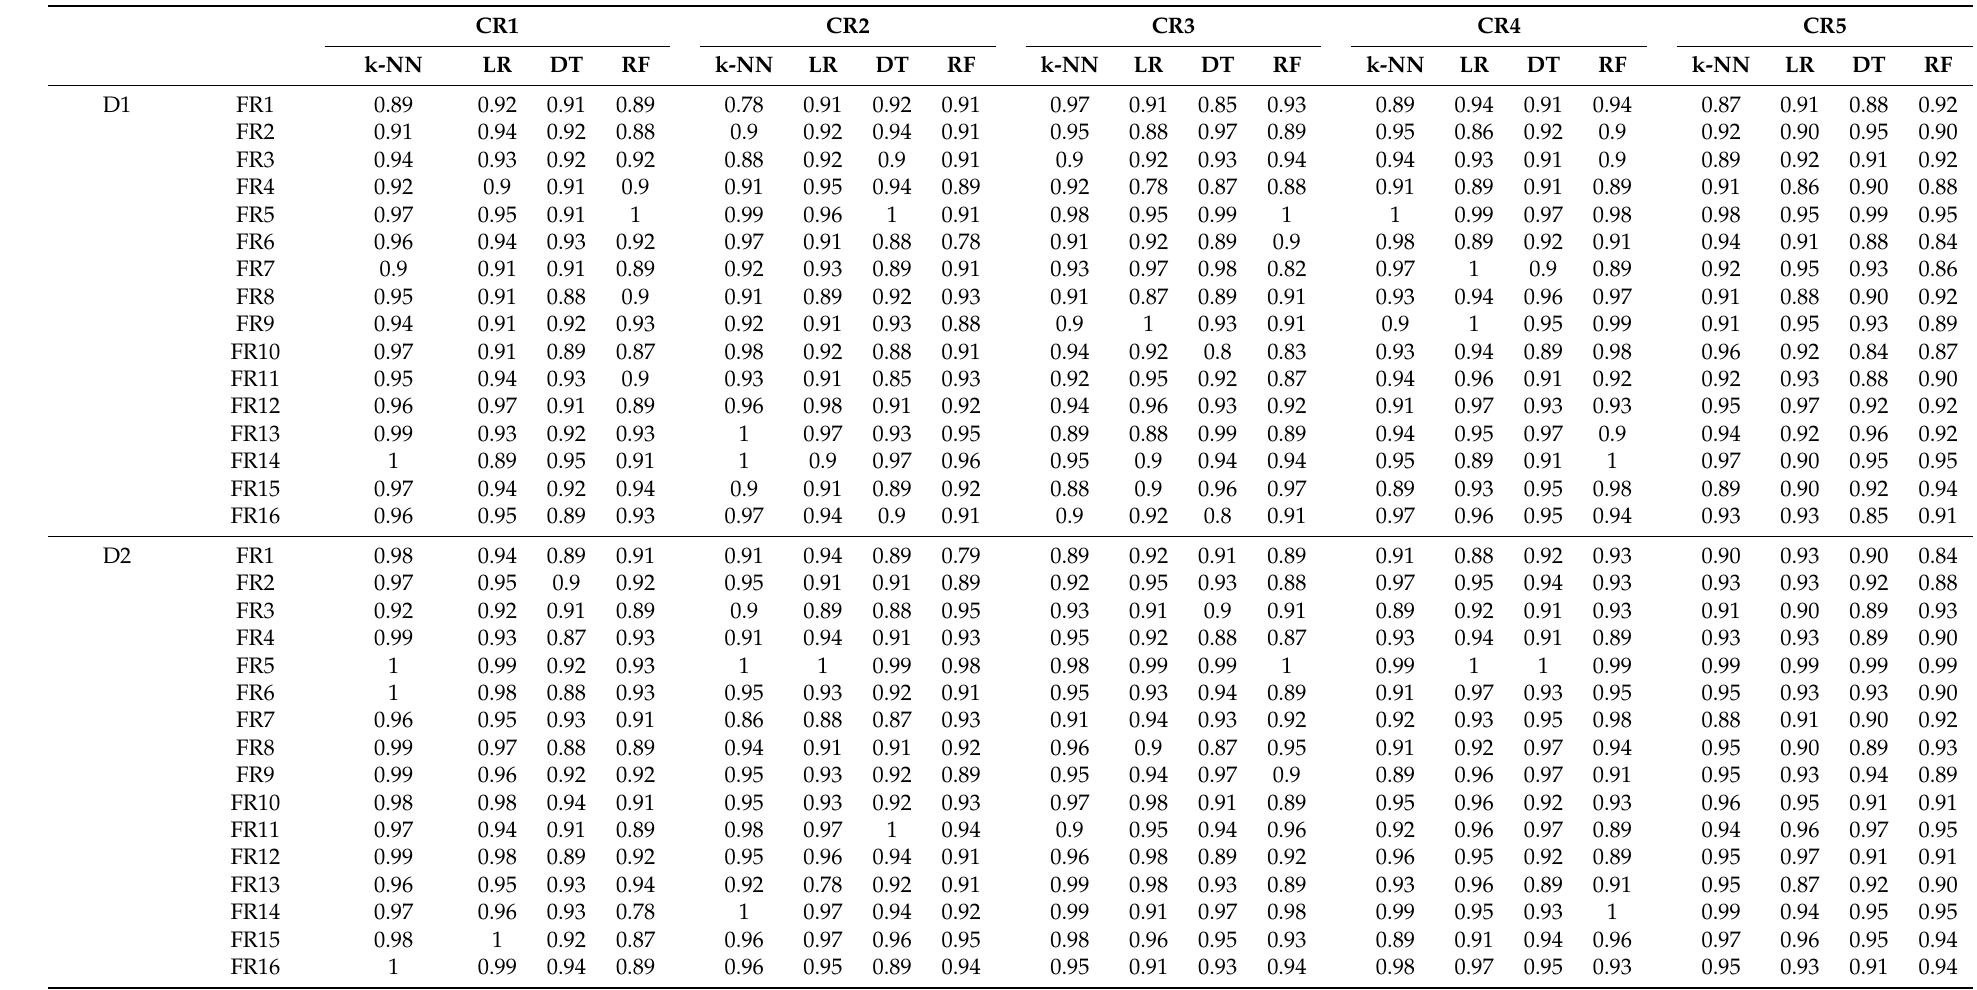
Table 3. Classification Results of Four Datasets By Using k-NN, LR, DT, and RF Classifier with Different Feature Ranking